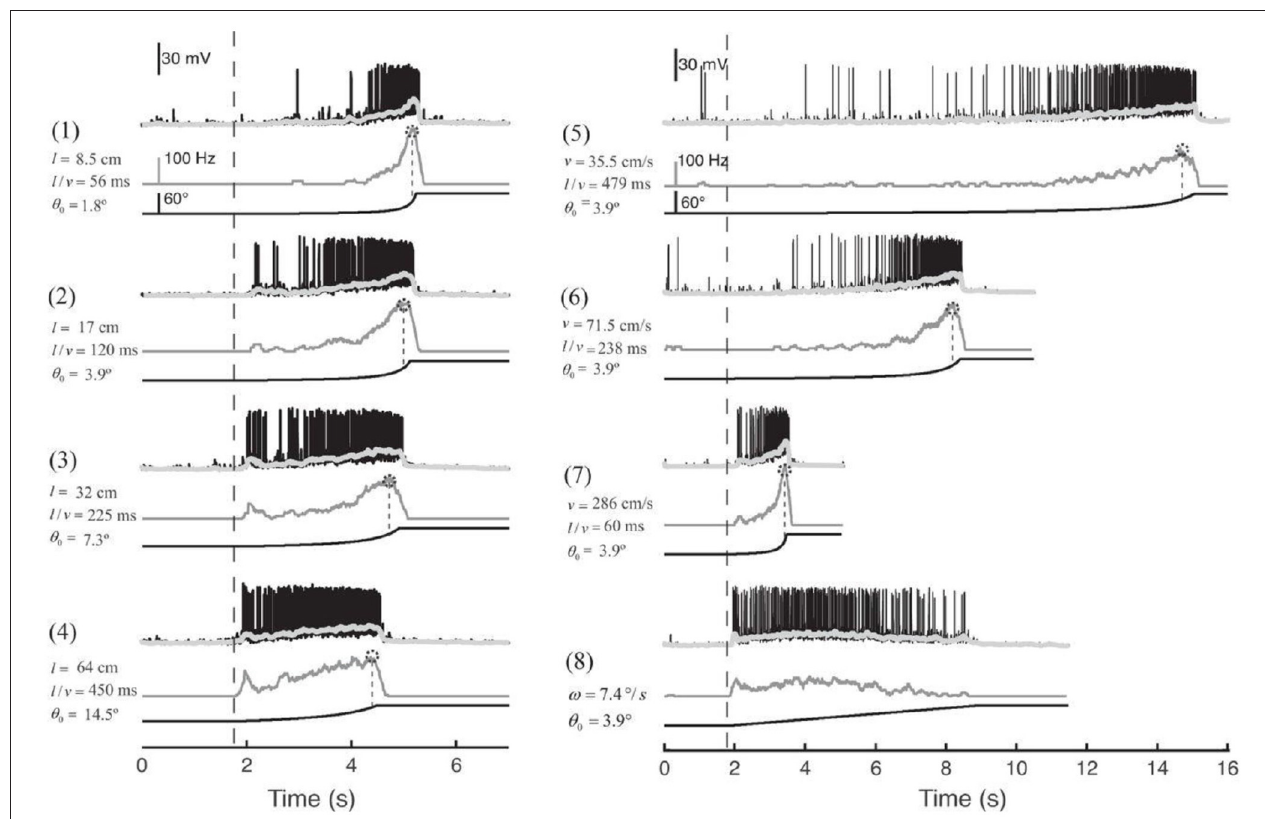
FIGURE 2 | Response of an MLG1 neuron to different looming stimuli. Looming stimuli parameters (stimuli 1–7): l is the half-size of the object. v is the approach speed. θ 0 is the initial angular size of the object in degrees. l / v is used to describe the dynamics in terms of time to collision. Black traces are real intracellular recordings from MLG1 neuron. Light gray traces are average membrane potential. Dark gray traces below correspond to the firing frequency. Dotted circles on the top of the lines are the peak of responses. The lines at the bottom are the stimuli image expansion. Dashed vertical lines signal the beginning of the stimulus expansion. Stimulus 8: black square expands at a constant angular velocity ω = 7.4 deg / s , adapted from Oliva and Tomsic